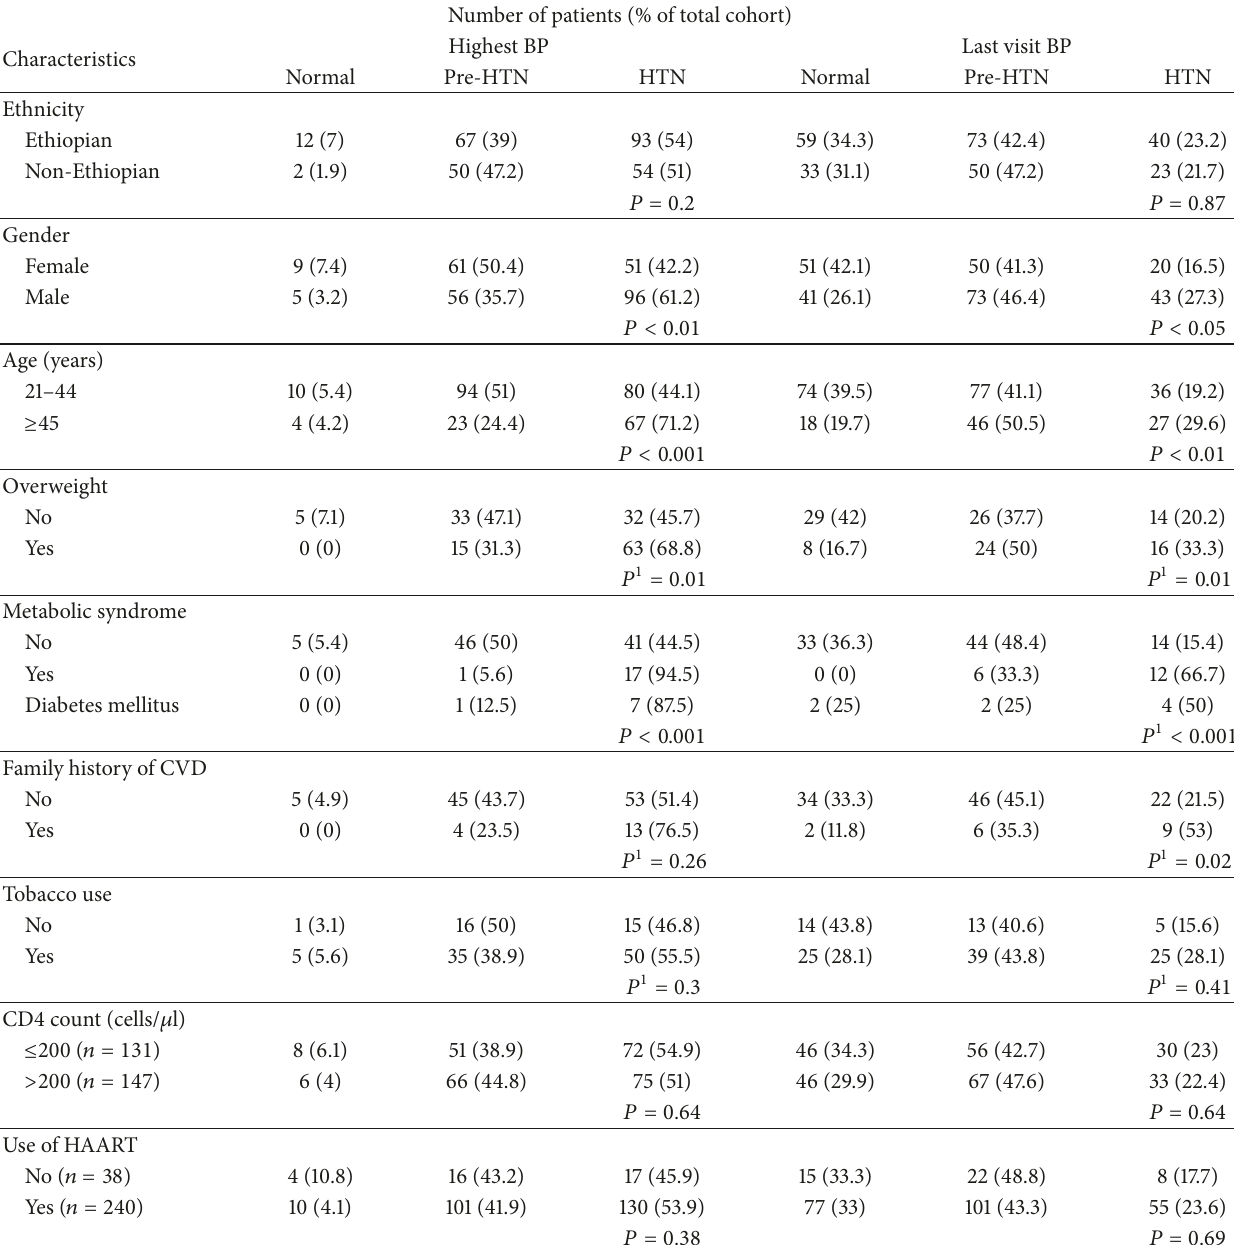
Table 1: Participants’ characteristics by three levels of BP at two time points of